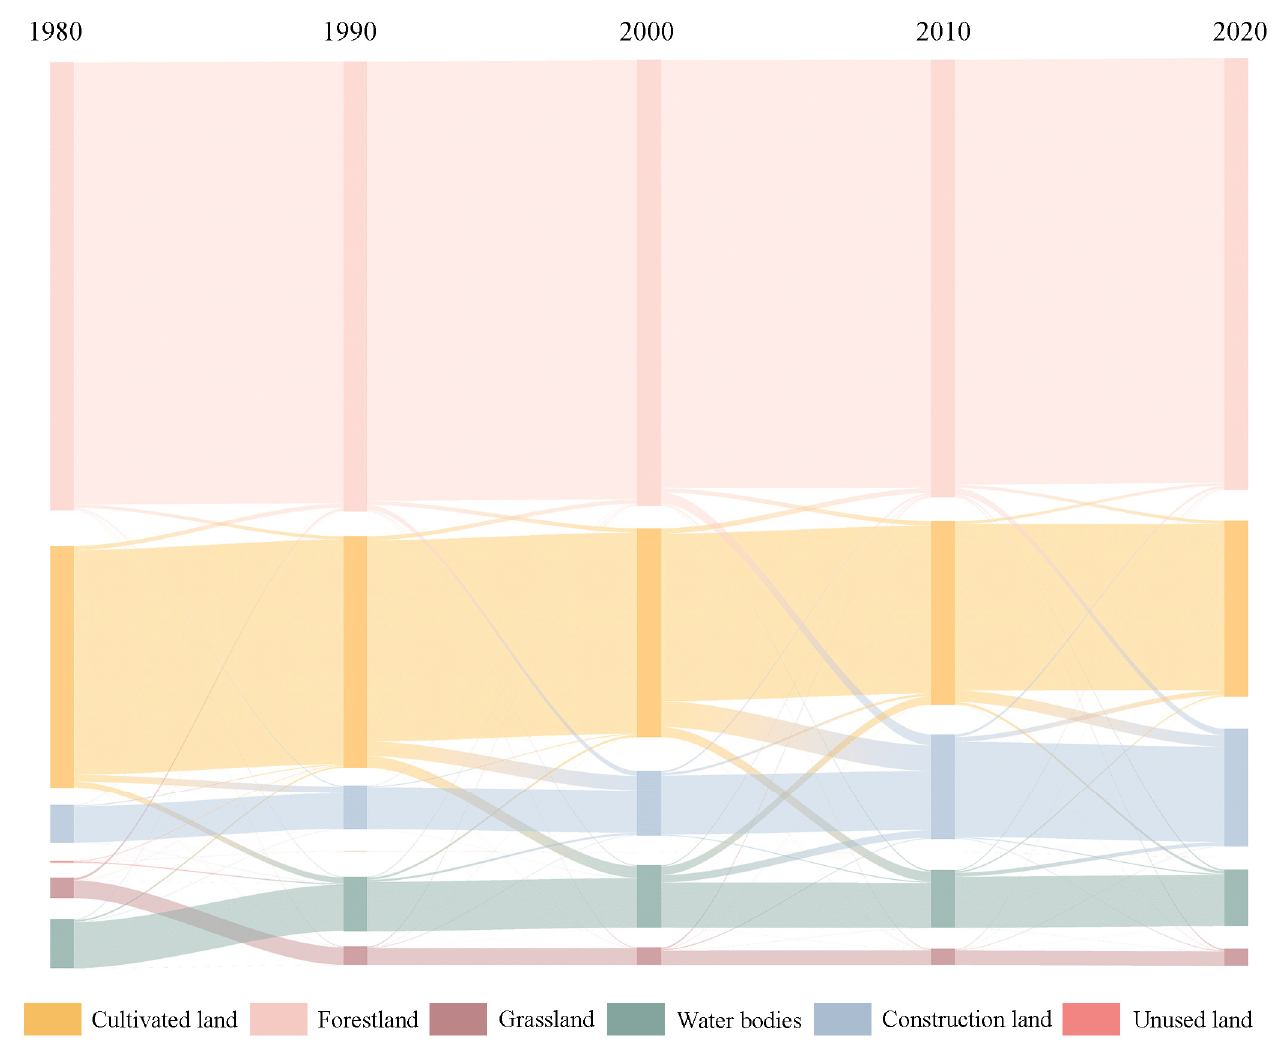
Figure 8. Sankey diagram of land use transfers from 1980 to 2020.